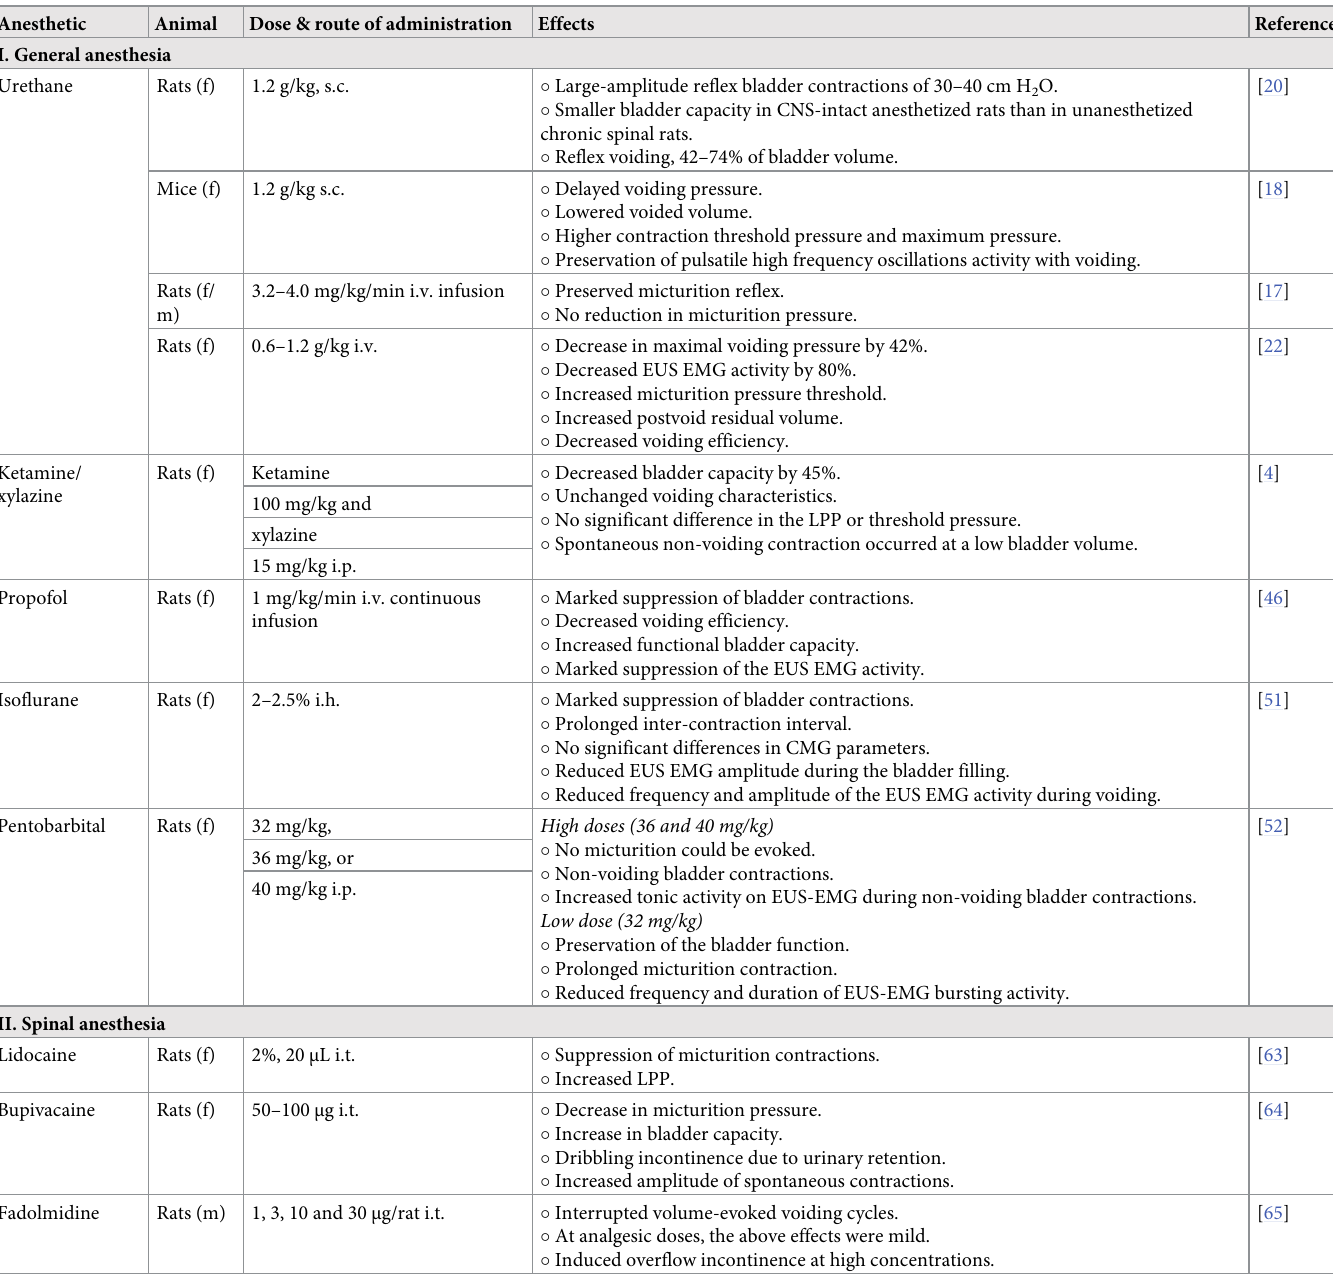
Table 1. Summary of anesthetic protocols used for urodynamic studies of lower urinary tract in rodents. Anesthetic Animal Dose & route of administration